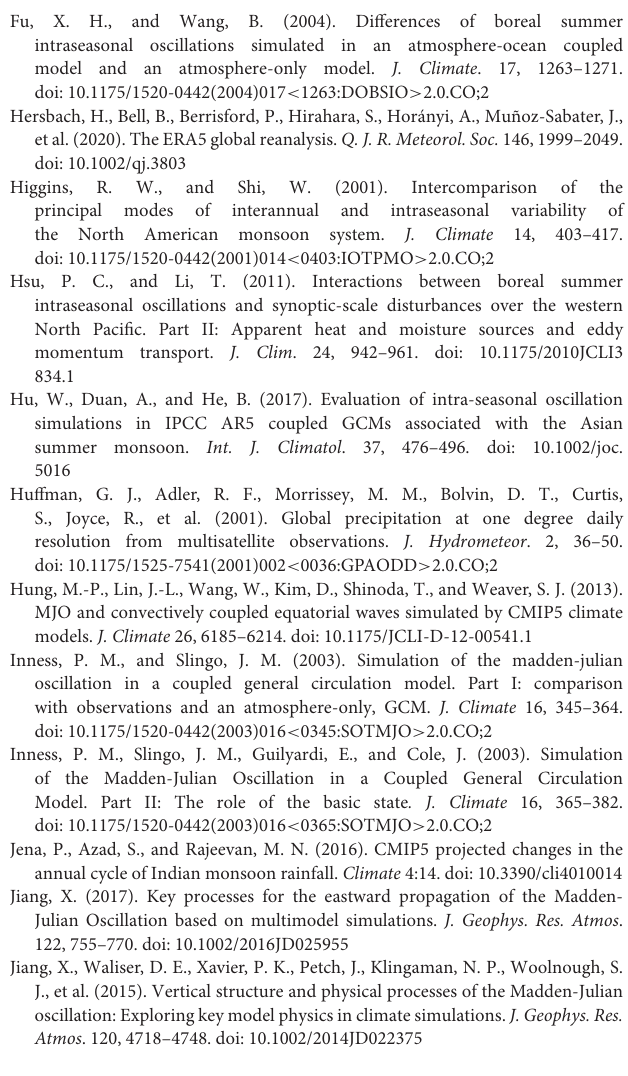
Supplementary Figure 2 | Phase-latitude Hovmöller plot of composite May–October 30–60-day OLR (shaded) and U850 (contour) anomalies averaged between 100 ◦ E and 120 ◦ E. Supplementary Figure 3 | Northward propagation of observed and simulation BSISO convection signal indicated by column integrated DSE (shaded) and 30–60-day rainfall anomalies (contours; starting from ± 0.2 to ± 0.6 at an interval of 0.2) averaged over 80 ◦ E–100 ◦ E by lag-correlation against 30–60-day rainfall anomalies averaged over the equatorial Indian Ocean (5 ◦ S and 5 ◦ N, 80 ◦ E and 100 ◦ E). Supplementary Figure 4 | Northward propagation of observed and simulation BSISO convection signal indicated by column integrated LSE (shaded) and 30–60-day rainfall anomalies (contours; starting from ± 0.2 to ± 0.6 at an interval of 0.2) averaged over 80 ◦ E–100 ◦ E by lag-correlation against 30–60-day rainfall anomalies averaged over the equatorial Indian Ocean (5 ◦ S and 5 ◦ N, 80 ◦ E and 100 ◦ E). Supplementary Figure 5 | Eastward propagation of observed and simulation BSISO convection signal indicated by column integrated LSE (shaded) and 30–60-day rainfall anomalies (contours; starting from ± 0.2 to ± 0.6 at an interval